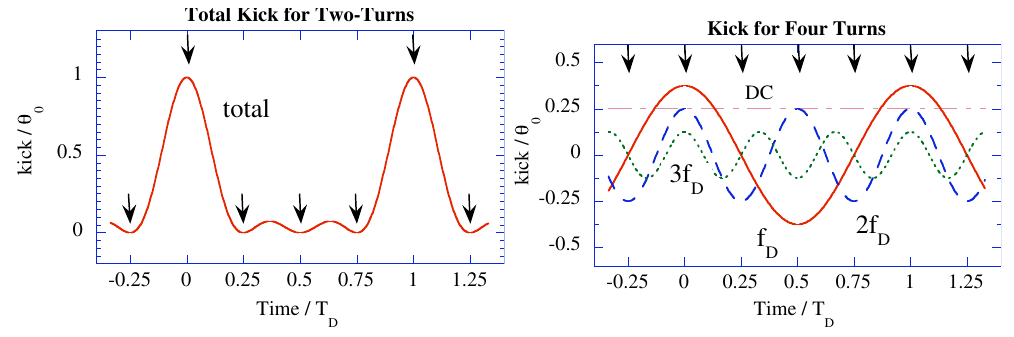
FIG. 4. (Color) Required deflection for four-turn system. Deflection by the system is shown in the left figure. In the right figure, the (solid), 2 f (dashed), and 3 f (dotted), and by four DC magnets (dot-dashed), are shown. The timing of deflections by cavities of f D D D = 4 , indicated by arrows. bunch passages is at every T D